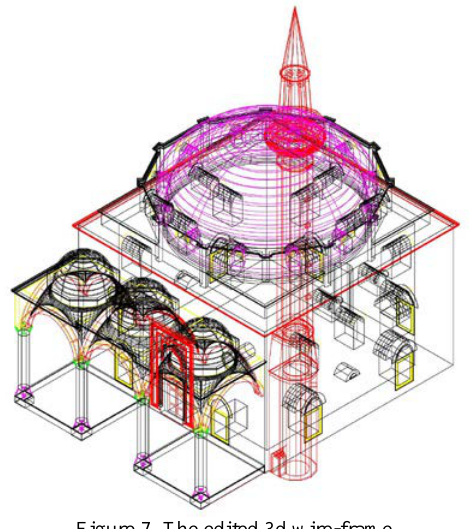
Figure 7. The edited 3d wire-frame